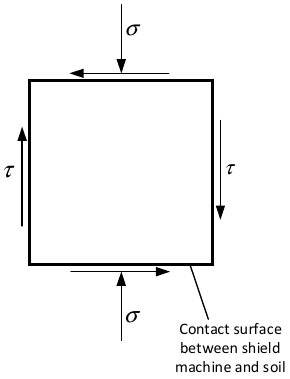
Contact surface between shield machine and soil Figure 15. Plane stress diagram of soil element. Figure 15. Plane stress diagram of soil element. Figure 15. Plane stress diagram of soil element.